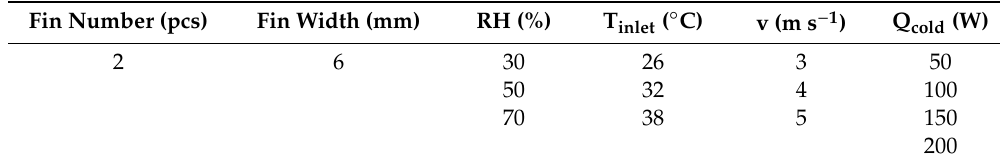
Table 1. Conditions parameters selected for sensitivity